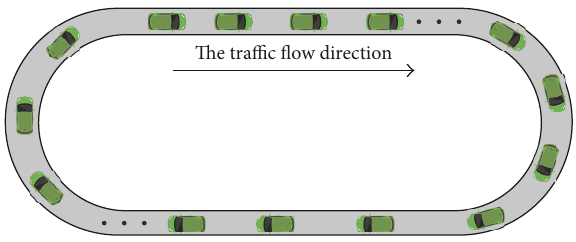
Figure 1: The schematic diagram of the vehicle